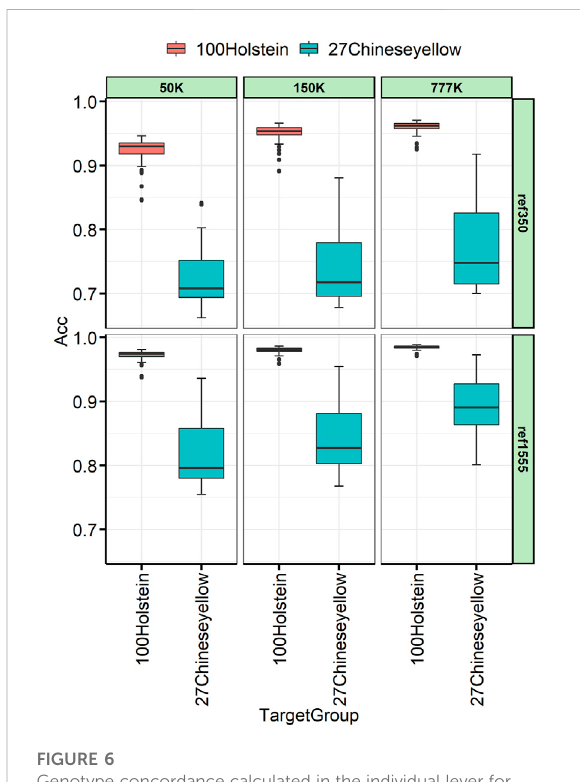
FIGURE 6 Genotype concordance calculated in the individual lever for 100 Holstein and 27 Chinese yellow cattle.